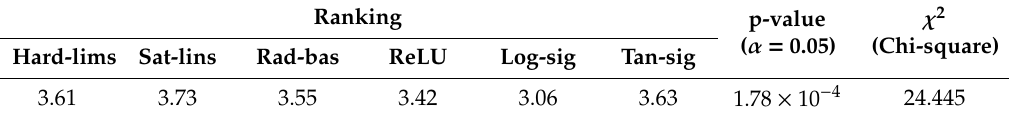
χ 2 ( α = 0.05) (Chi-square)